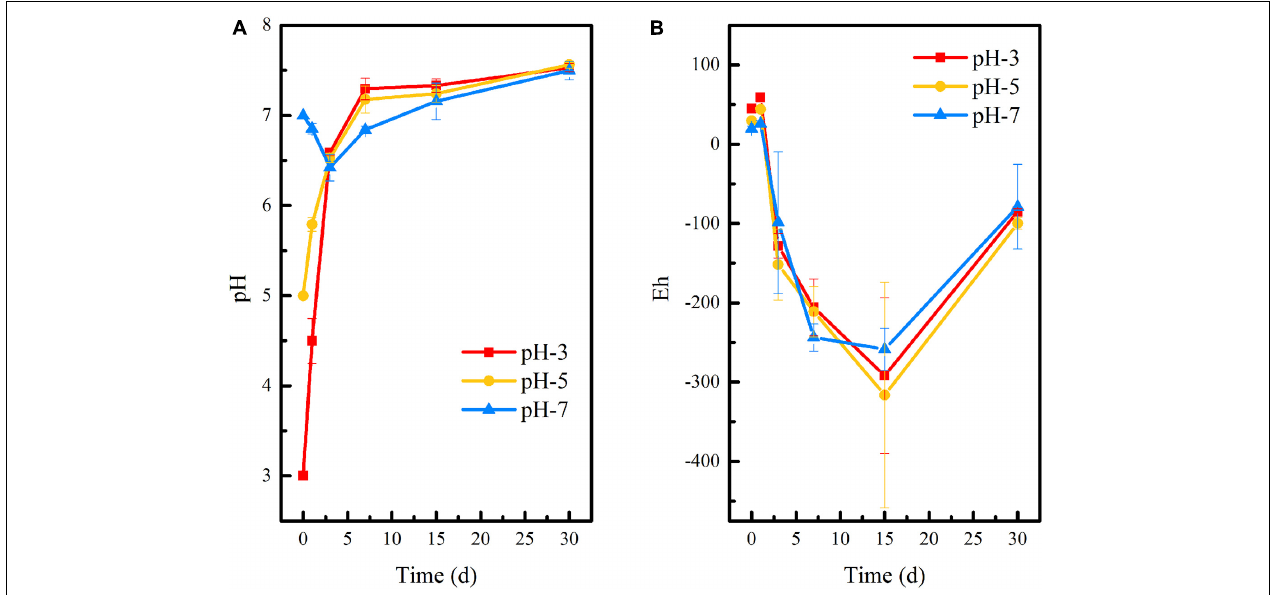
FIGURE 1 | Changes of (A) pH and (B) Eh during the microbial stabilization process of SRB-PSB under different pH.